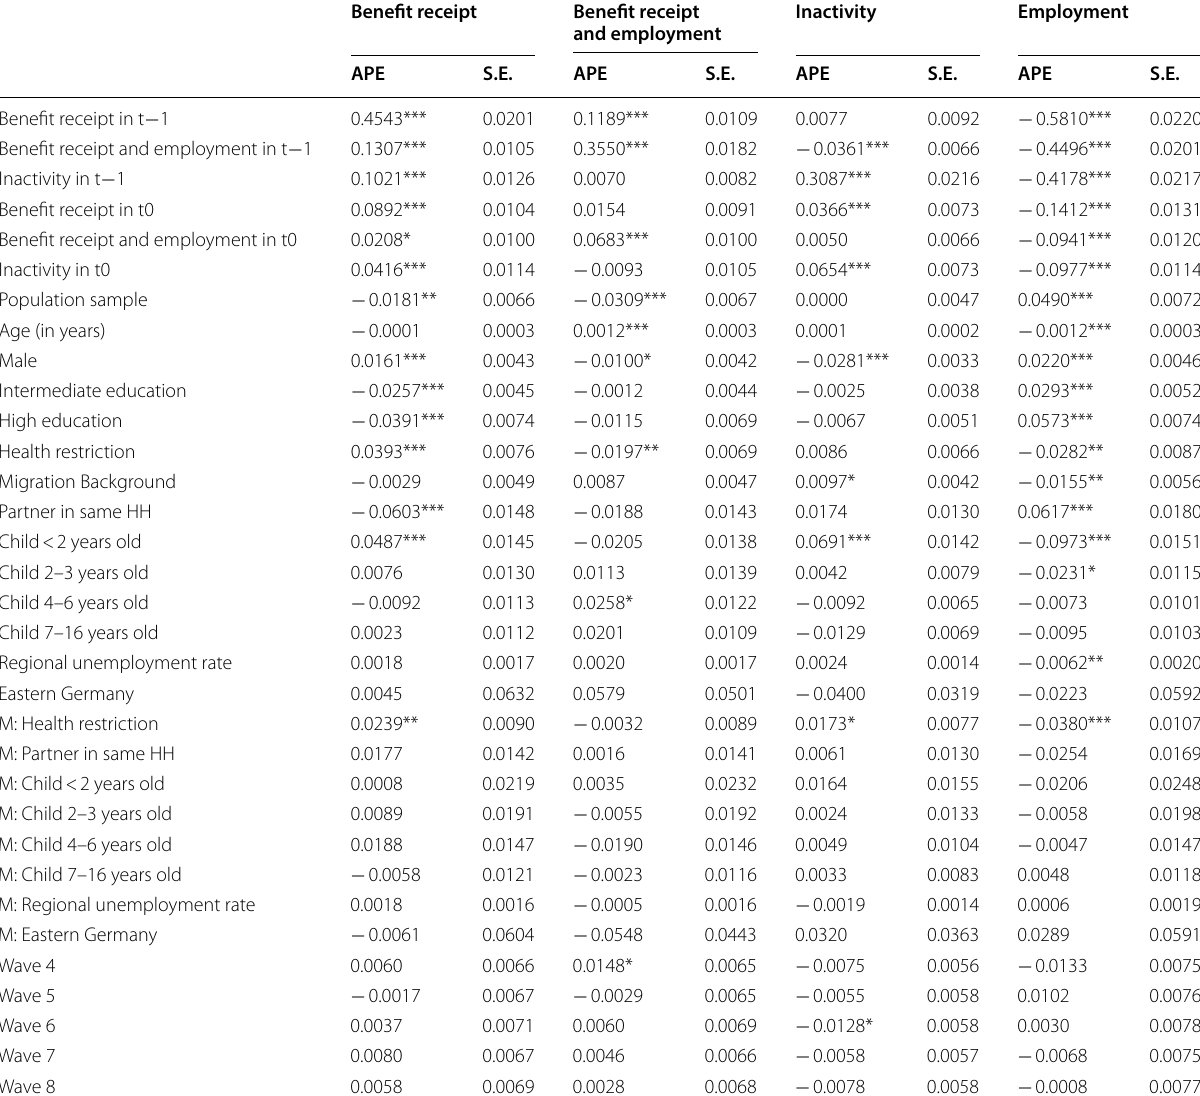
Table 14 Average partial effects of all explanatory variables on the probability to be in a given state in t (administrative